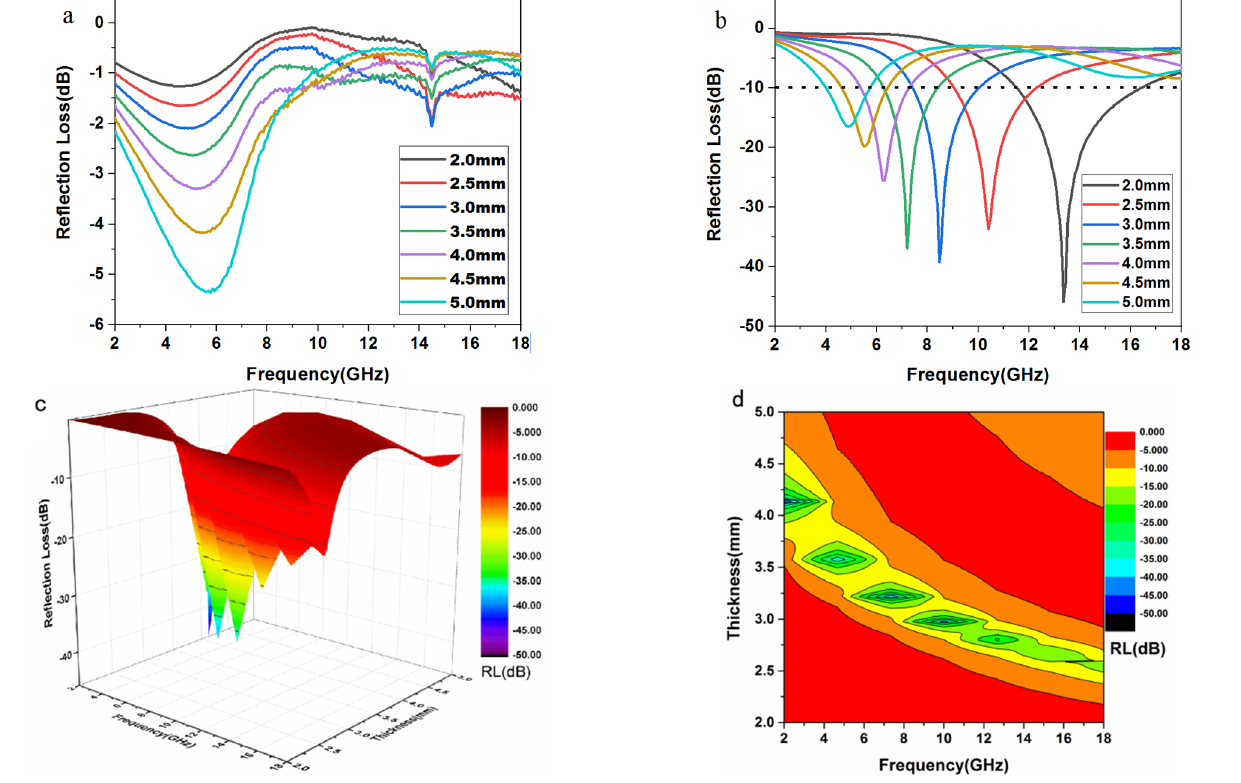
Figure 8. RL of ( a ) Fe 3 O 4 nanoparticles, ( b ) RGO/Fe 3 O 4 nanocomposites, ( c ) 3D RL values of RGO/Fe 3 O 4 nanocomposites, ( d ) 2D RL projection map for RGO/Fe 3 O 4 Table 1. The electromagnetic wave absorption or shielding property of relative absorbers.